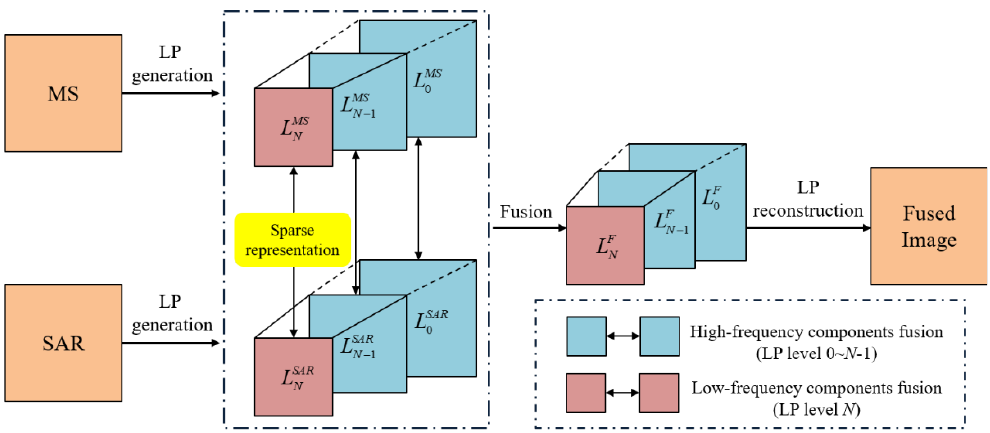
Figure 1. Schematic diagram of proposed fusion